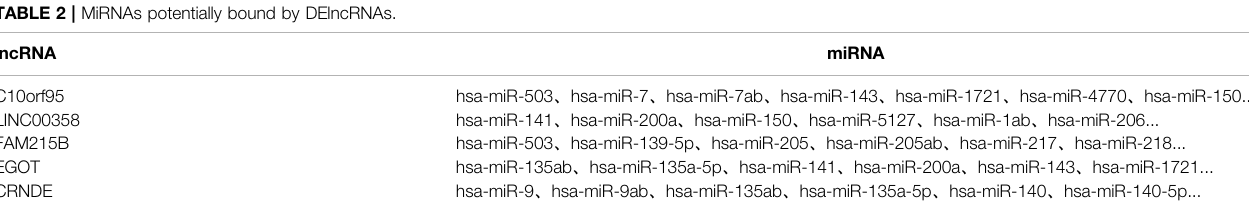
TABLE 2 | MiRNAs potentially bound by